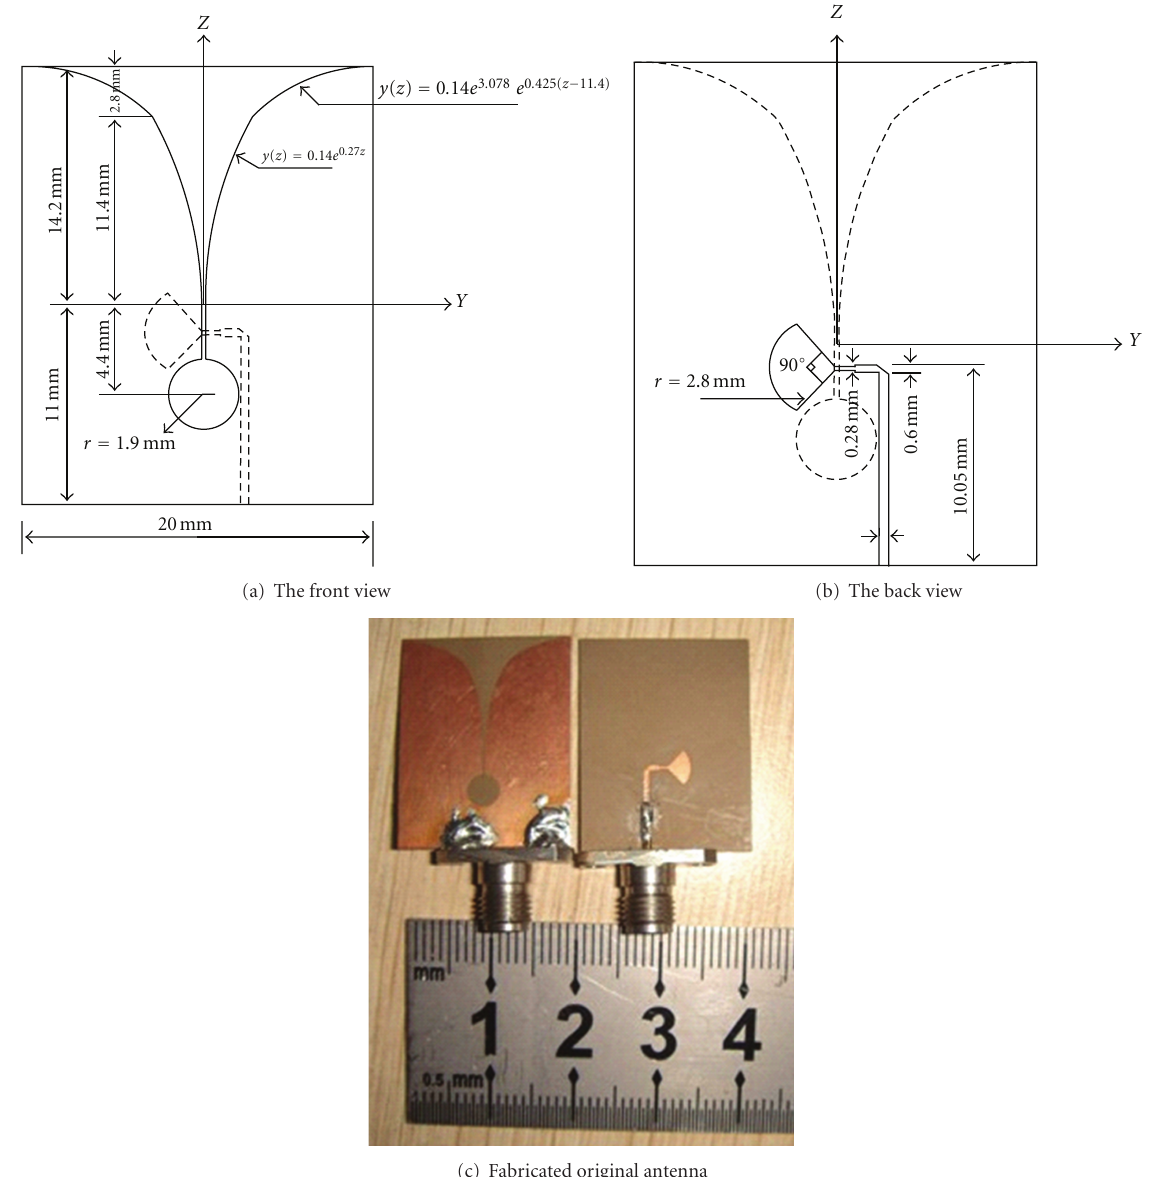
Figure 1: Structure of original Vivaldi